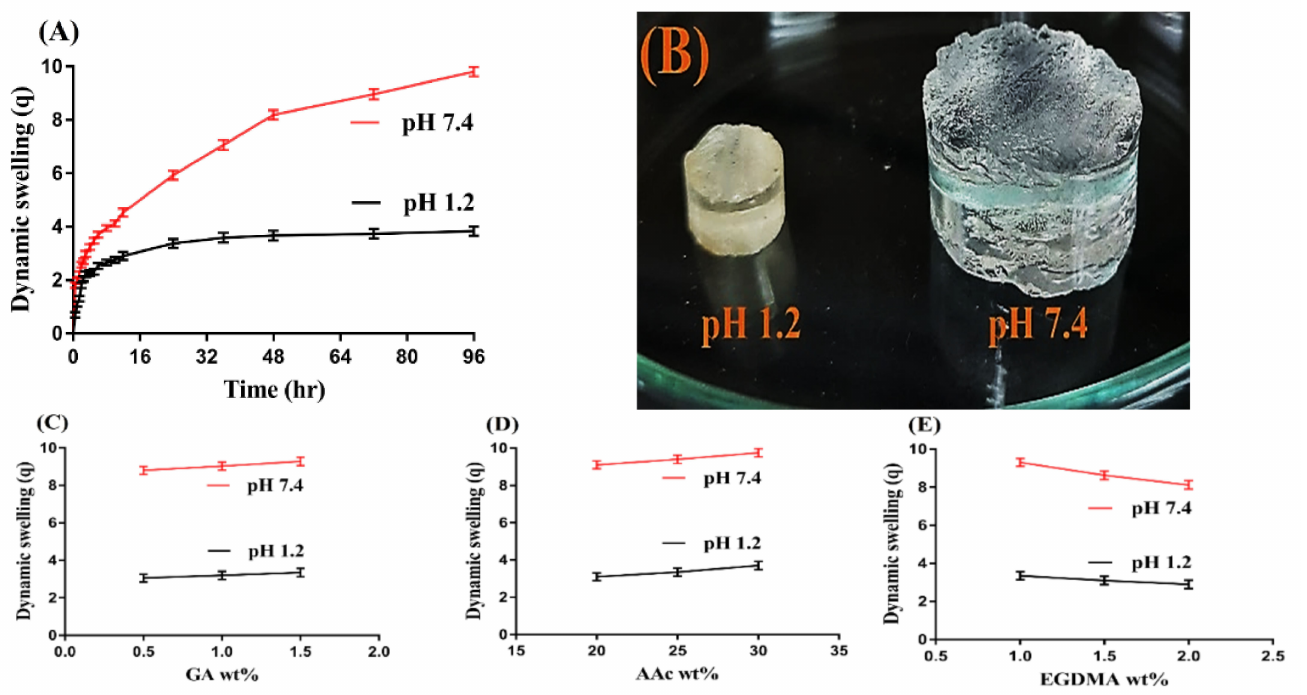
Figure 4. ( A ) Effect of pH on dynamic swelling, ( B ) swelled hydrogel at pH 1.2 and 7.4; effects of ( C ) GA, ( D ) AAc, and ( E ) EGDMA on dynamic swelling of GAcPAAc